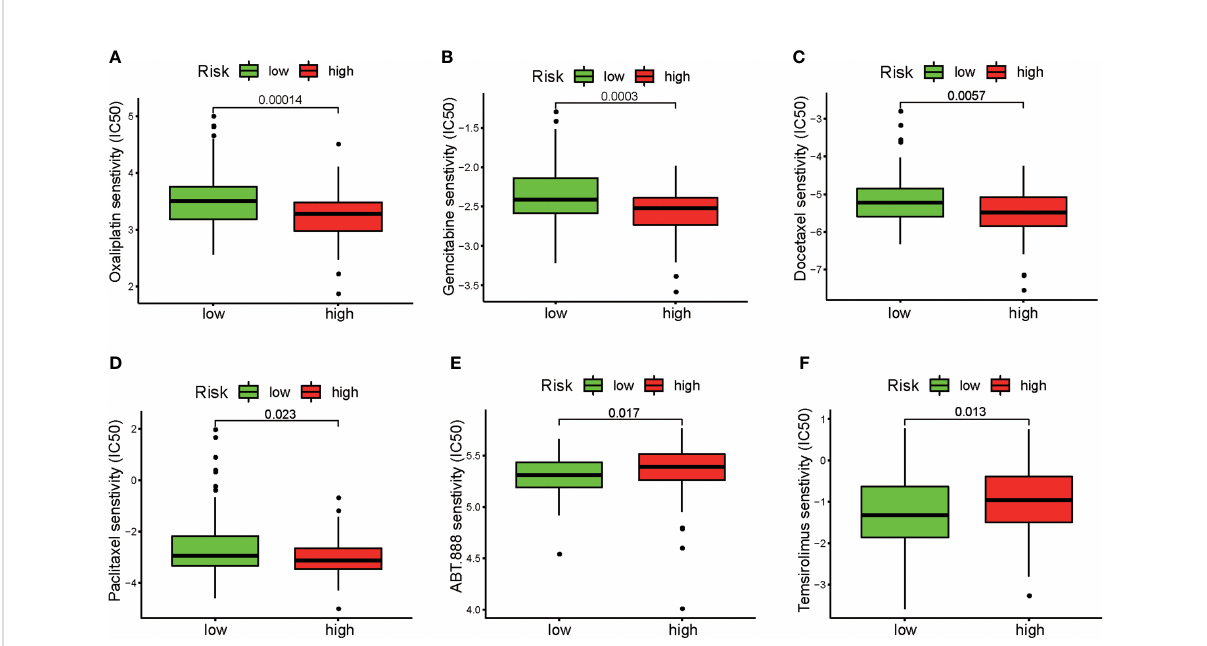
FIGURE 9 Evaluation of sensitivity to chemotherapeutic drugs and target therapeutic agents in the two risk groups. Differences between the high-risk and low-risk groups in response to chemotherapy based on IC 50 values for (A) oxaliplatin, (B) gemcitabine, (C) docetaxel, and (D) paclitaxel. Differences between the high-risk and low-risk groups in response to targeted therapy based on IC 50 values for (E) the PARP inhibitor ABT.888 and (F) the mTOR inhibitor